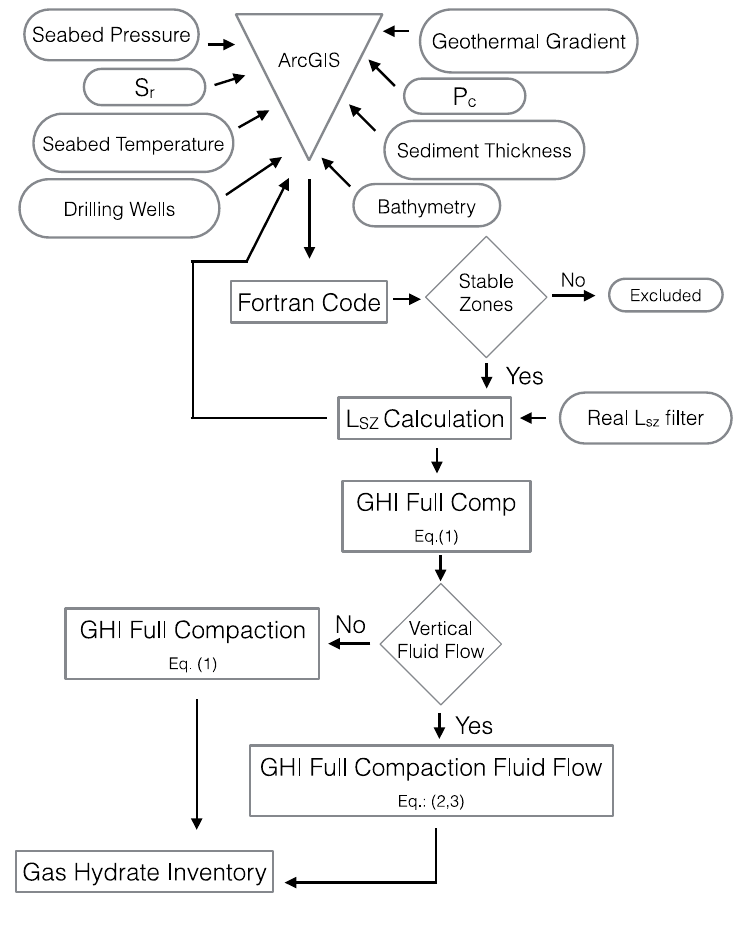
Figure 3. Methodology flow